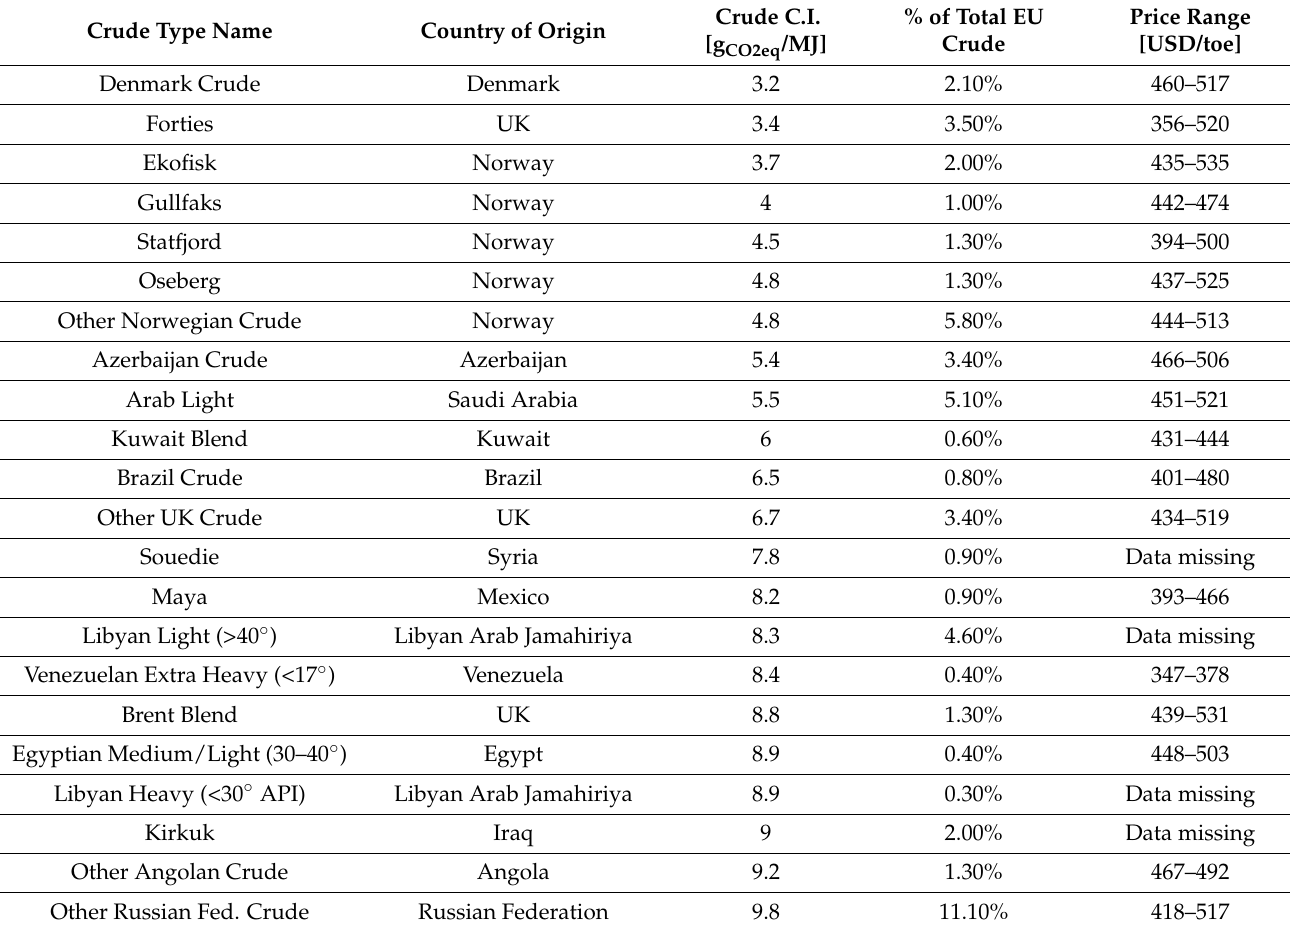
Table A1. EU imported or internally produced crude streams, with CI lower than the average, as defined in Baseline B. Crude Type